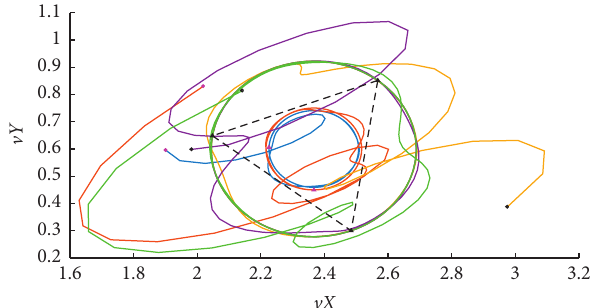
Figure 2: The trajectory of agents’ velocities over time without time delay.